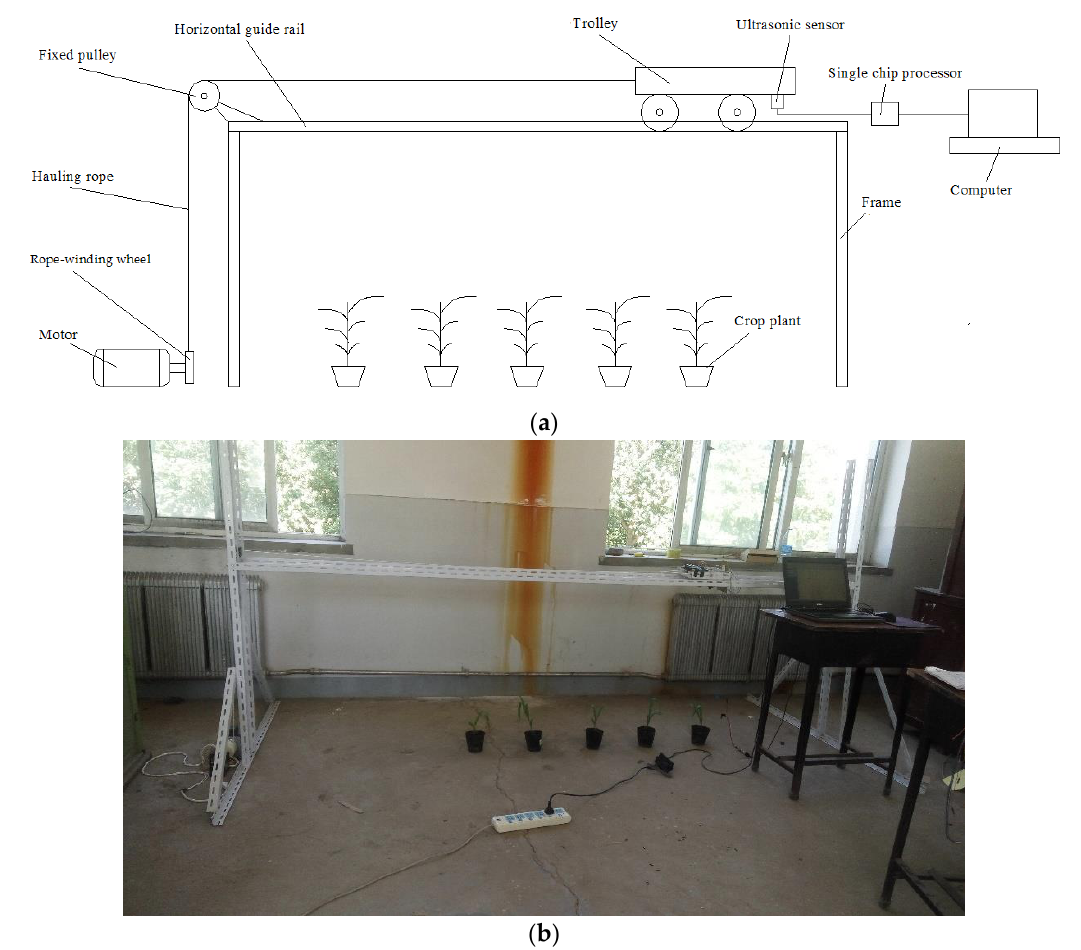
Figure 1. Experimental apparatus: ( a ) Schematic diagram; ( b ) Actual photo.